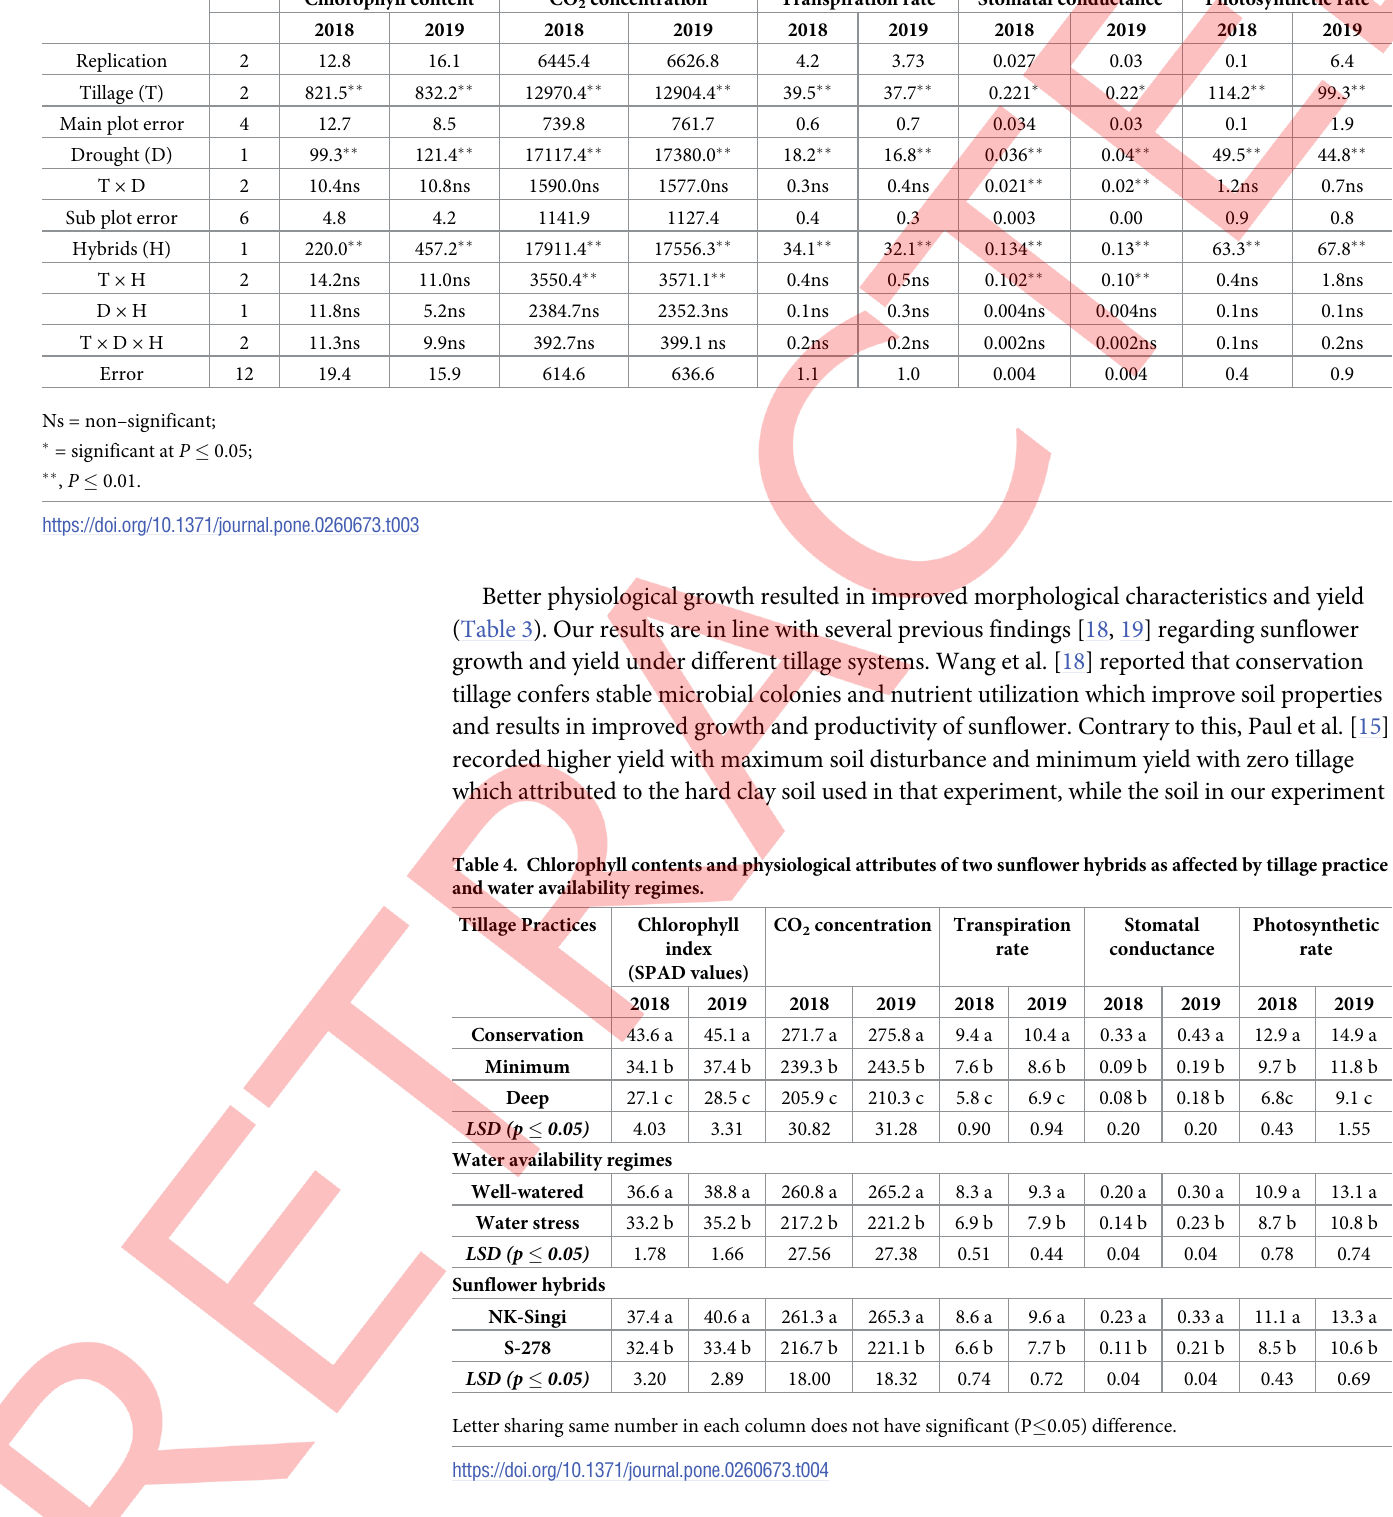
Table 3. Analysis of variance (ANOVA) of chlorophyll index and physiological traits of sunflower hybrids as influenced by various tillage practices and water regimes. Source df